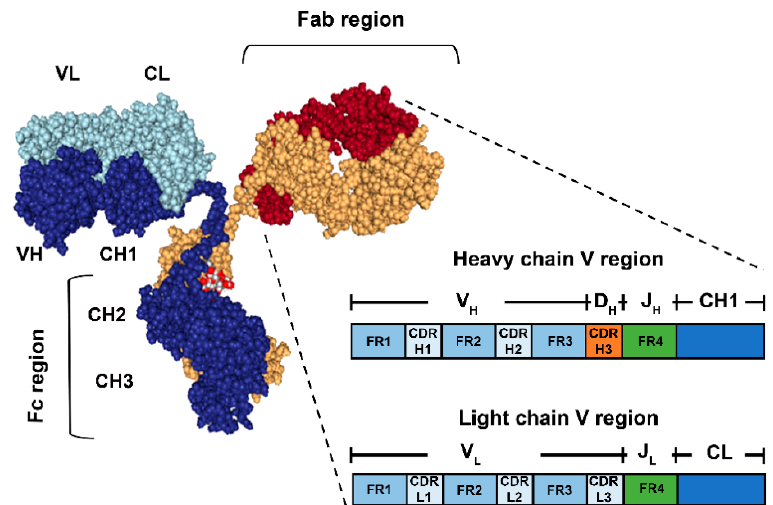
Figure 1. Schematic representation of the basic antibody structure (Immunoglobulin G) and detailed view of a Fab. The antibody is composed of two heavy chains (dark blue and yellow) and two light chains (light blue and red). The Fab regions contain the Variable fragments of the heavy and light chains (VH and VL respectively), where the antigen-binding site is located. The zoomed in view of the Fab shows the relevant regions contained in each of the H and L chains, namely Framework 1,2, 3 and 4 (FR1,2,3,4) and Complementarity-determining Regions 1, 2 and 3 (CDRH/L1,2,3) (Not shown at scale).It is indicated as well, which of the Ig gene segments (V(D)J) codify for each of the regions after somatic recombination and rearrangement during B cell maturation. On the other hand, the Fc region contains the H chain constant segments 2 and 3 (CH2,3).